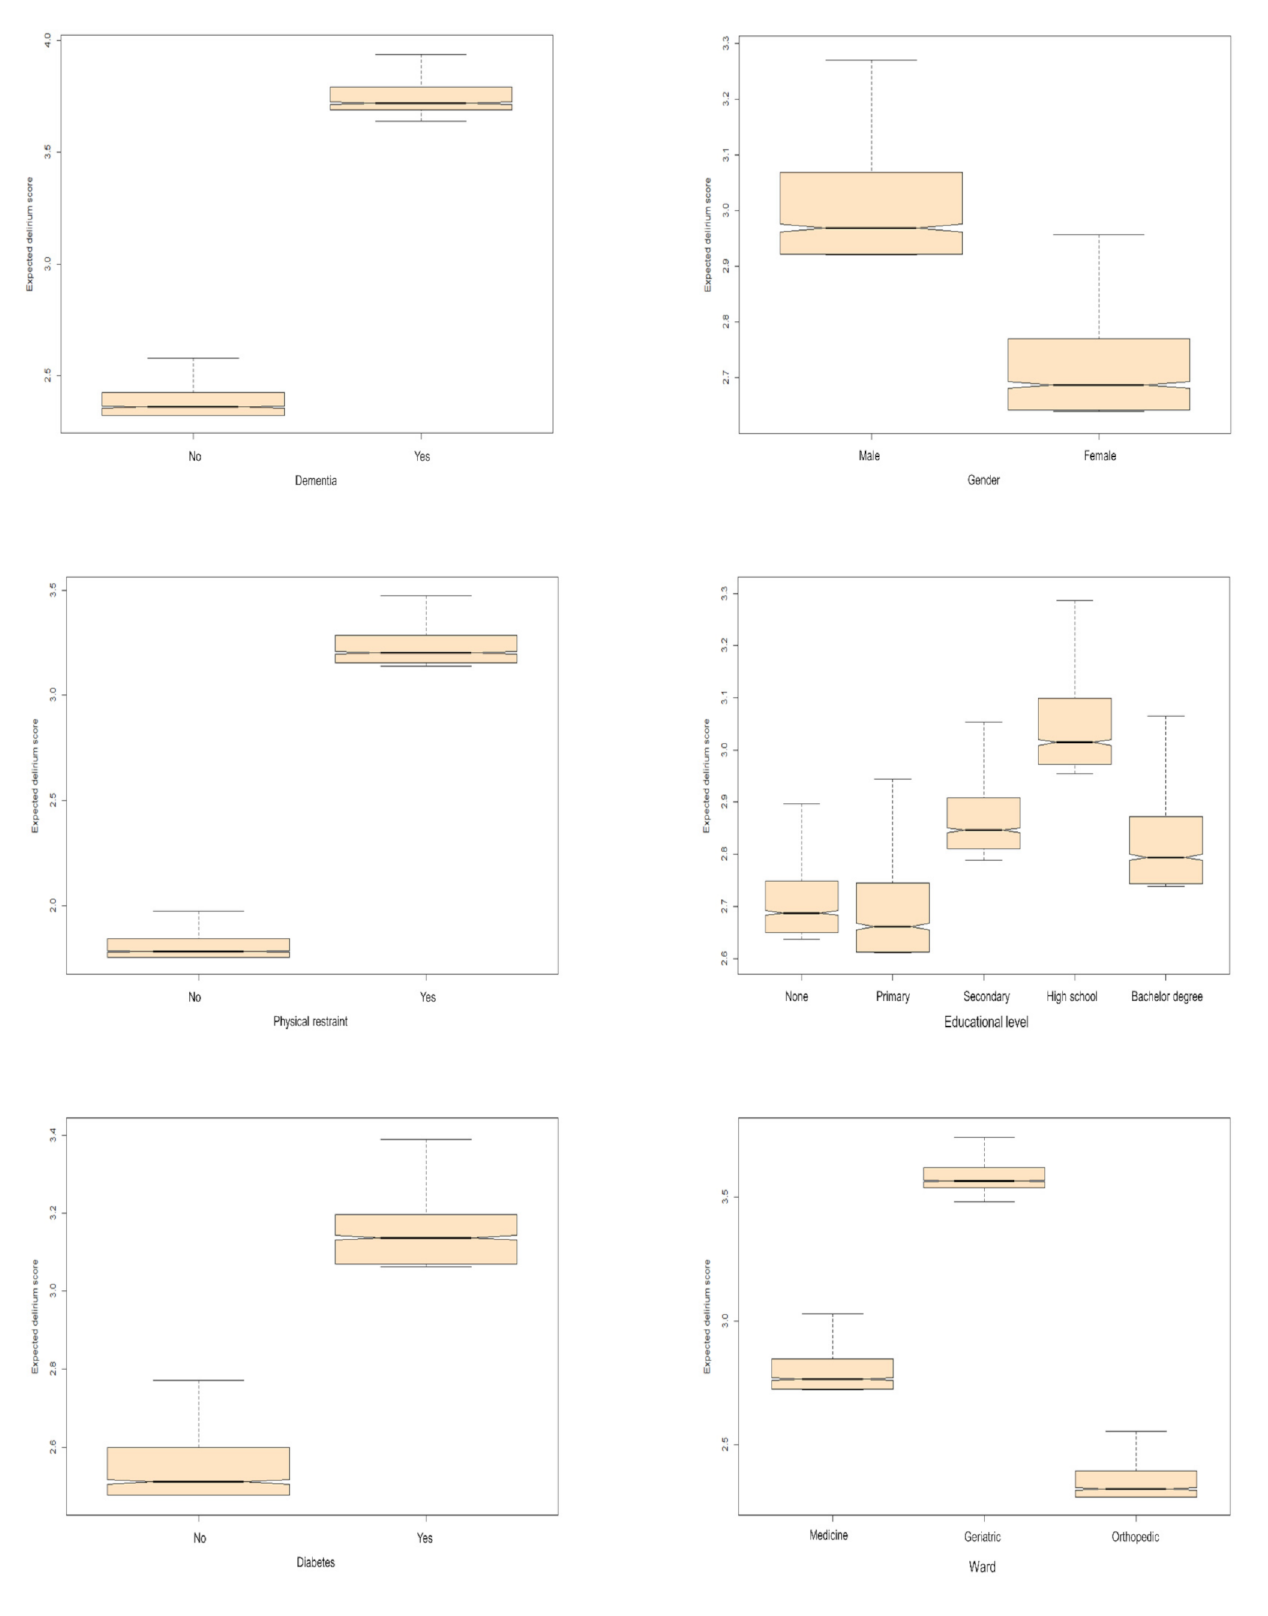
Figure 4. Effect of the presence of dementia, gender, physical restraint, educational level, diabetes, ward, antibiotics, and previous admissions on the 4AT delirium score. The vertical axis displays the ensemble expected predicted delirium